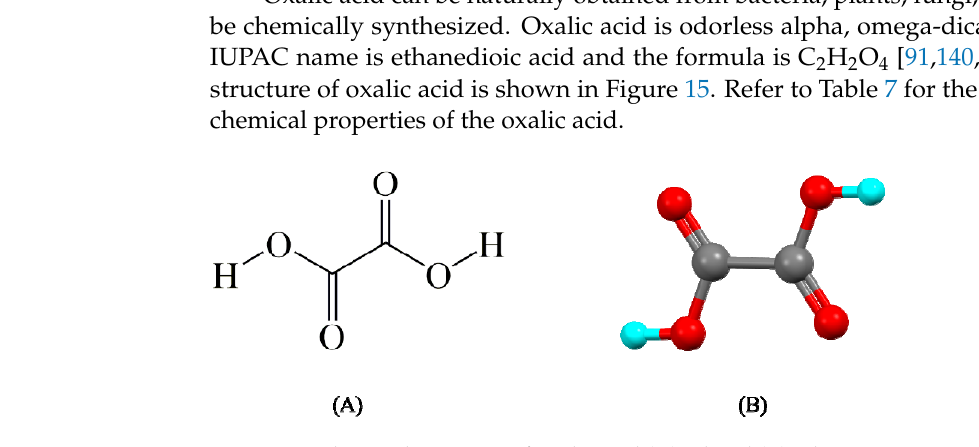
Figure 15. Chemical structure of oxalic acid ( A ) 2d and ( B ) 3d.